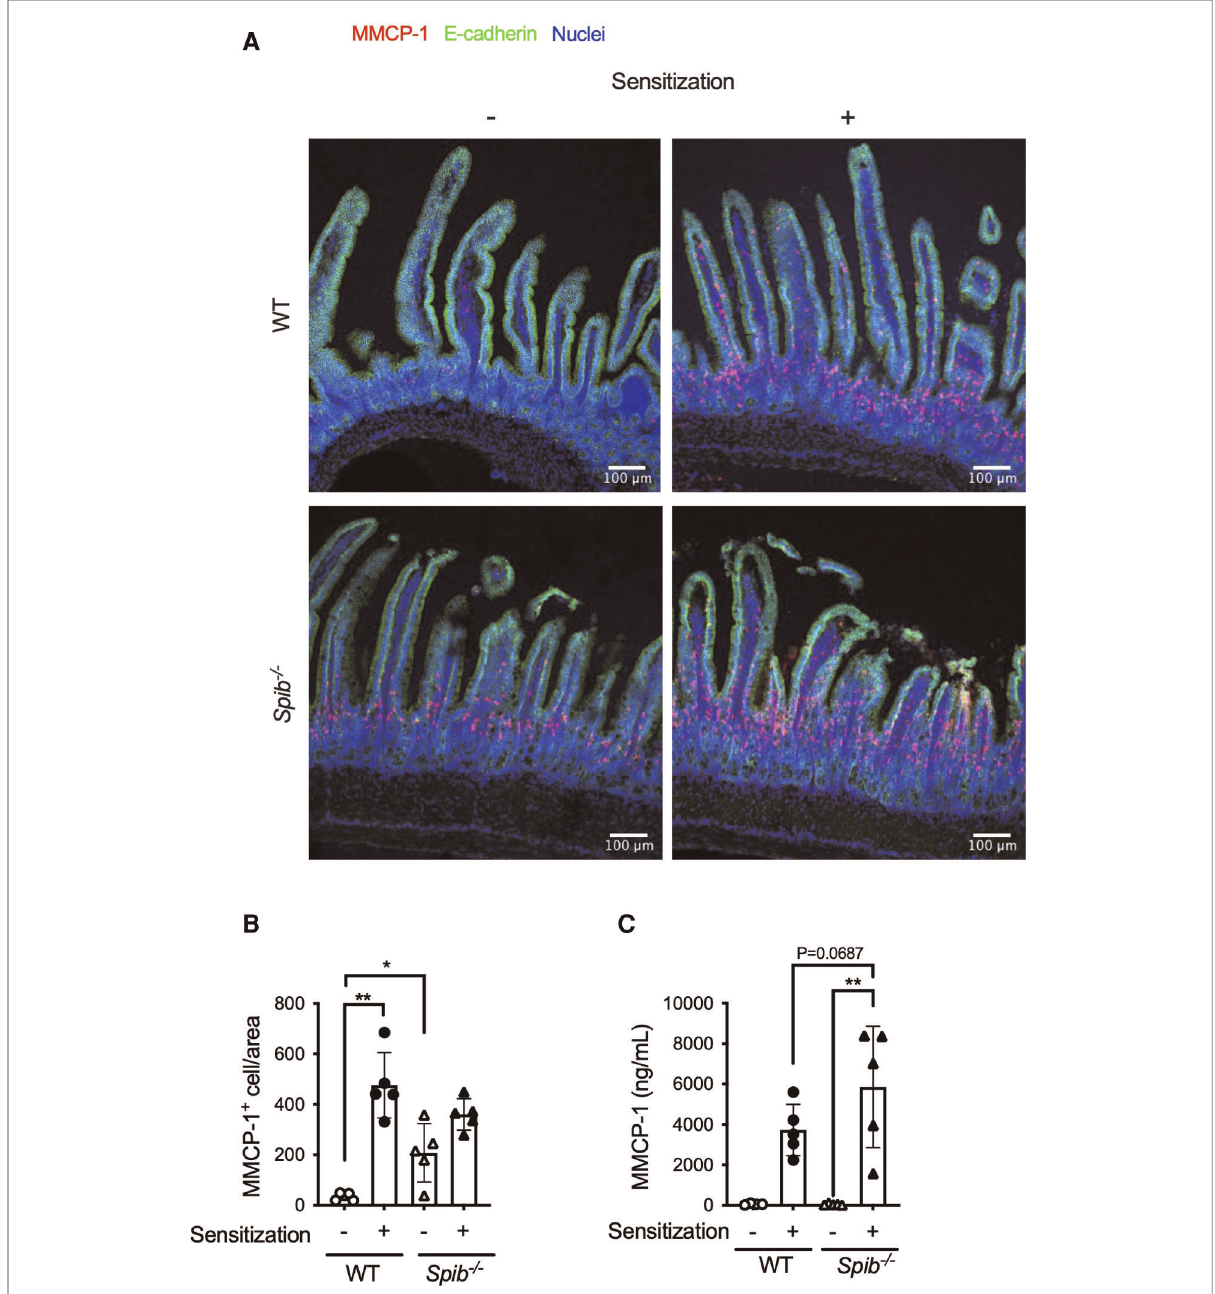
FIGURE 3 Spi-B de fi ciency increases intestinal mast cell activity. ( A ) Immuno fl uorescent images of the upper small intestine after OVA challenge (day 20). MMCP-1 + mast cells (red), E-cadherin (green), and nucleus (blue) are shown. Scale bars, 100 µ m. ( B,C ) The number of MMCP-1 + mast cells in the intestine ( B ) and MMCP-1 level in the serum ( C ) were measured on day 20. Representative data from at least two independent experiments are shown. Data are expressed as mean±SEM ( n =5 or 6). * p <0.05, ** p <0.01, calculated by Kruskal – Wallis test for ( B,C